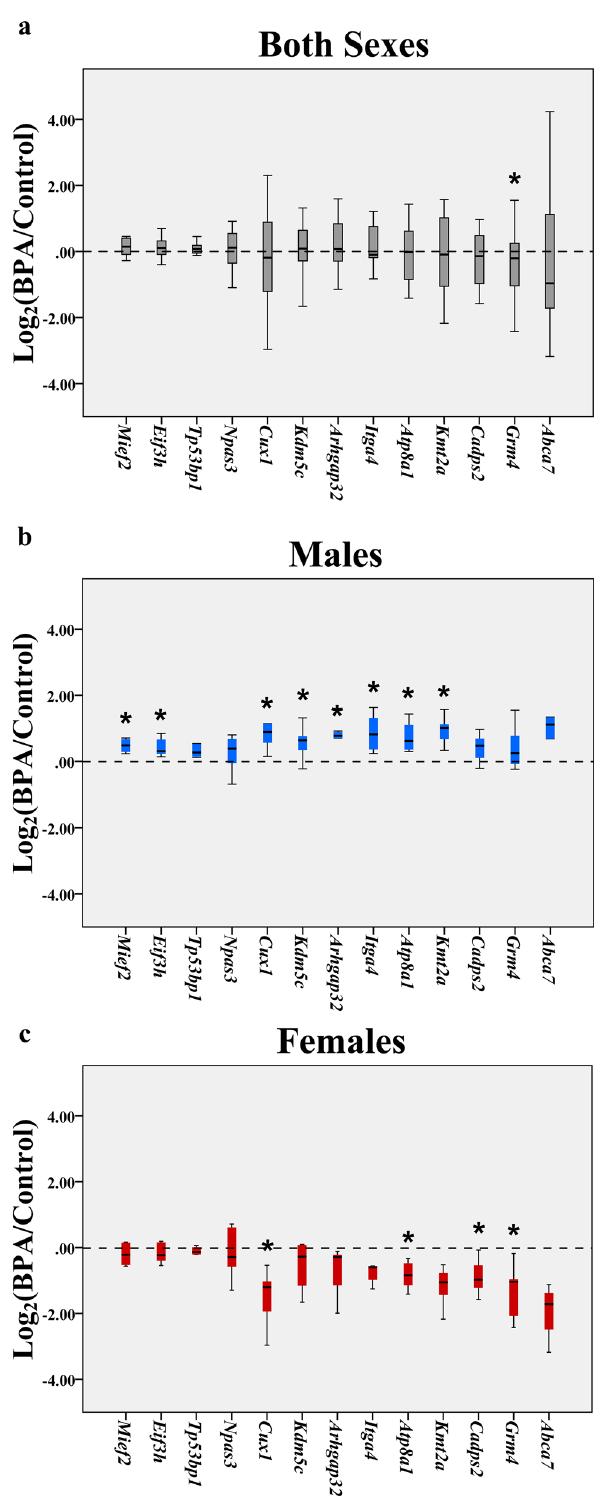
Figure 1. Box plot of the expression levels of DEGs involved in neuronal cell death, neuritogenesis, and learning/memory in the hippocampus of offspring. Quantitative RT-PCR analysis of the hippocampus of offspring (PND1) prenatally exposed to BPA or the vehicle control was performed to assess the expression levels of the selected genes when both sexes of offspring were combined ( a ), in male offspring only ( b ), and female offspring only ( c ). * P value <